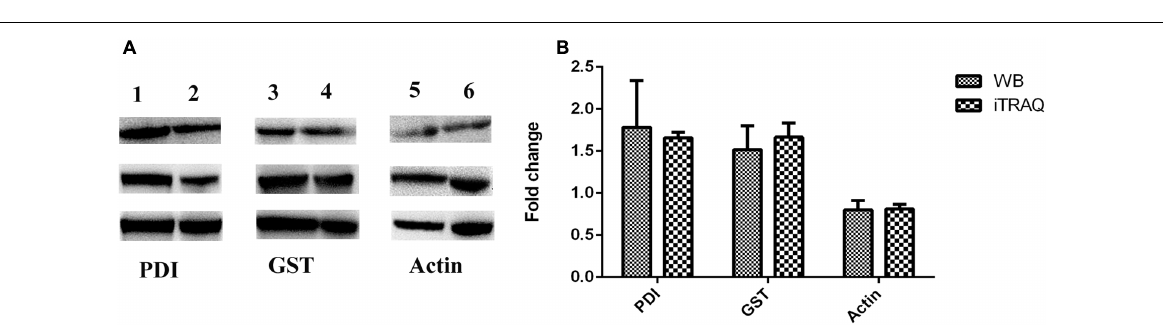
FIGURE 6 | Confirmation of differentially expressed proteins by Western blotting. Each experiment was repeated three times. (A) Immunoblot analysis of proteins ( Sj PDI, Sj GST, and actin) in adult schistosome from water buffalo and yellow cattle. Lane 1, Sj PDI of water buffalo group. Lane 2, Sj PDI of yellow cattle group. Lane 3, Sj GST of water buffalo group. Lane 4, Sj GST of yellow cattle group. Lane 5, actin of water buffalo group. Lane 6, actin of yellow cattle group. (B) WB ratios (water buffalo group/yellow cattle group) were consistent with those obtained by